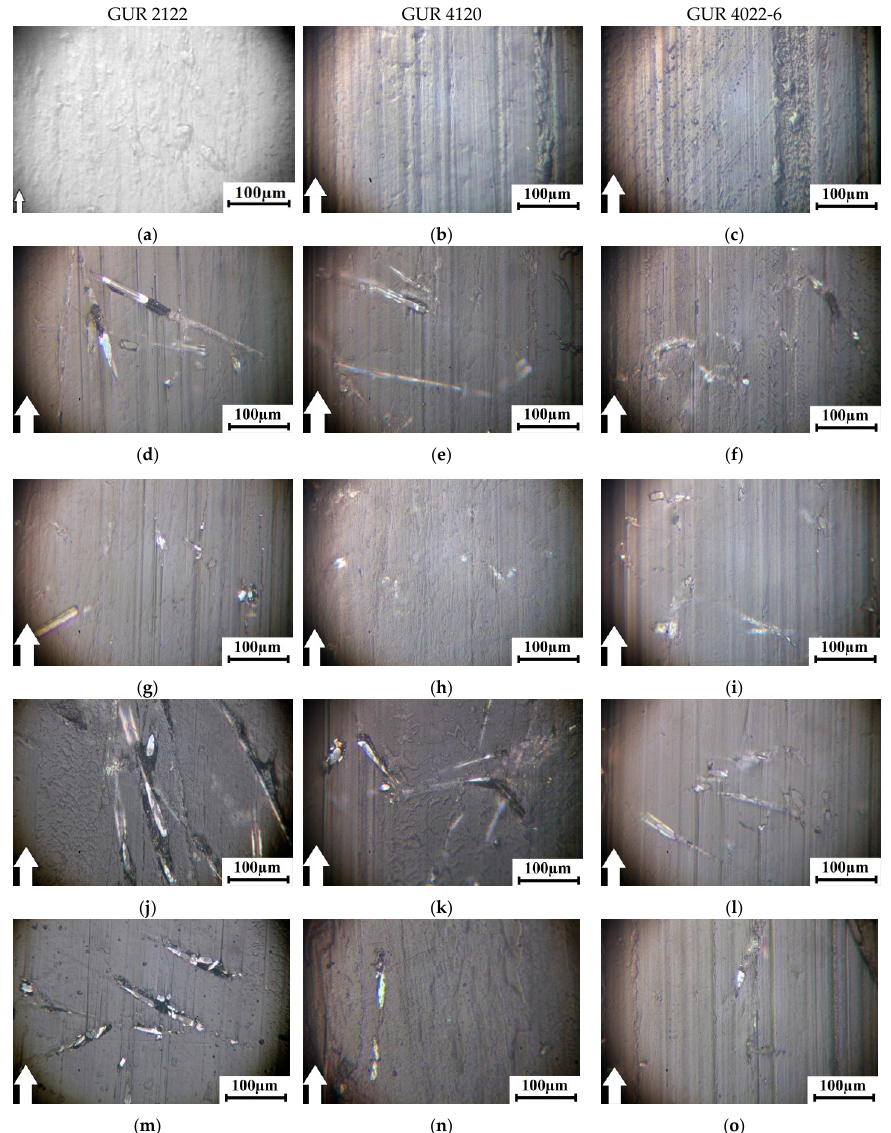
Figure 10. Optical images of the wear track surfaces of the neat Ultra High Molecular Weight PolyEthylene UHMWPE sample and its composites at 60 N × 0.3 m/s: based on the GUR 2122 powder ( a, d, g, j, m ); based on the GUR 4120 powder ( b, e, h, k, n ); based on the GUR 4022-6 powder ( c, f, i, l, o ).